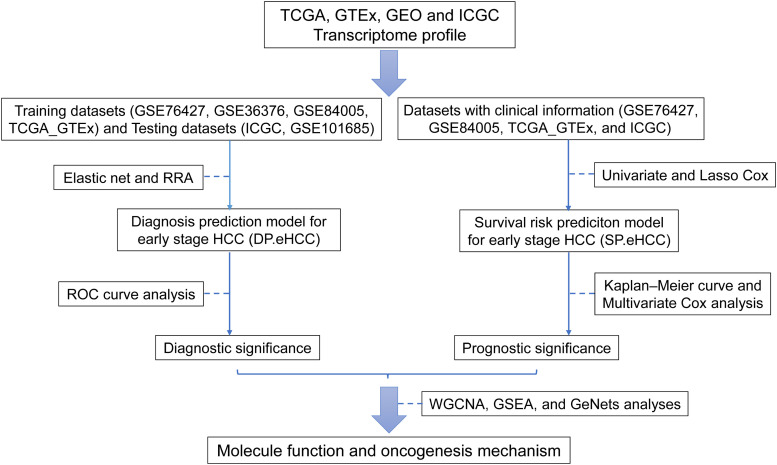
Flow diagram of the main procedure in our study. Six datasets from four international platforms were utilized to establish the diagnosis model and prognosis model. Their clinical significance and molecular mechanism were further elucidated.